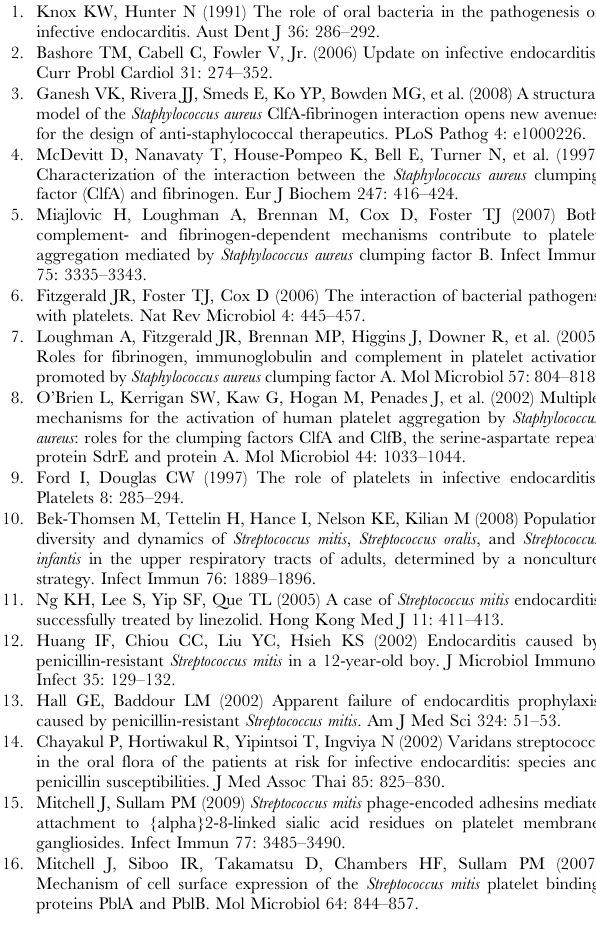
Figure S6 Detection of LTA phosphocholine (PC) residues. Samples (1 m g) were separated by electrophoresis through 4–12% NuPAGE Bis-Tris gels (Invitrogen) and transferred onto nitrocel- lulose membranes. LTA were detected with mouse anti-PC monoclonal antibody (TEPC-15; Sigma-Aldrich). Table S1 Strains and plasmids DOC) Table S2